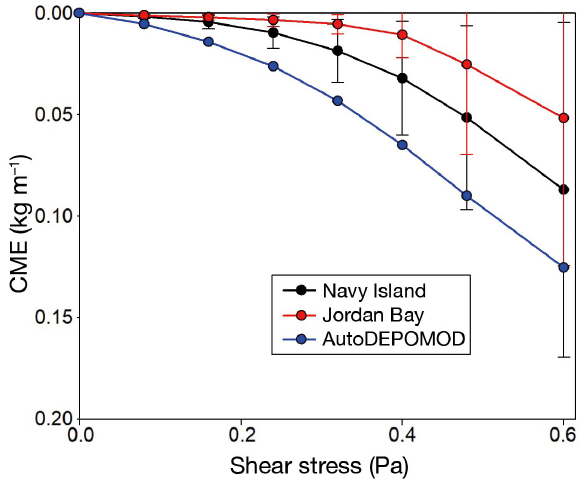
Fig. 10. Average cumulative mass eroded (CME) from Jordan Bay and Navy Island from all samplings. AutoDEPOMOD also shown as average CME using the AutoDEPOMOD erodibility parameter, M , set to 7.0 × 10